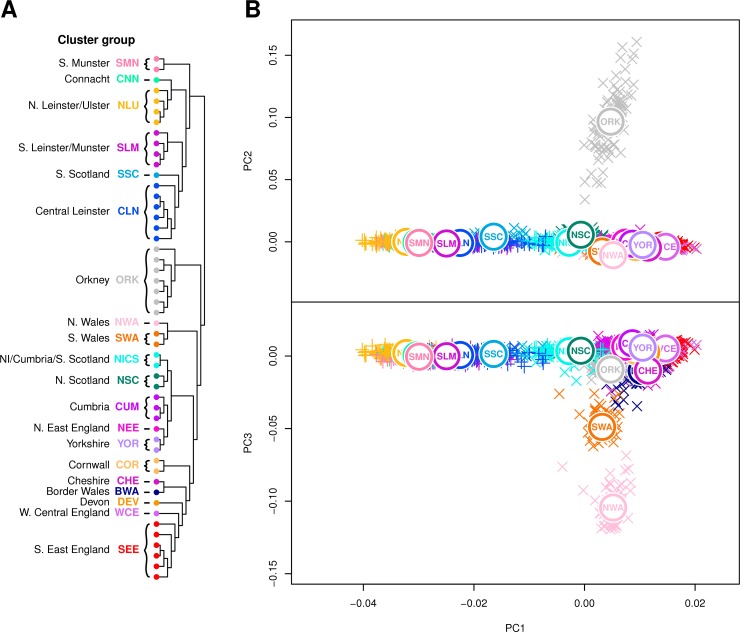
Principal components 2 and 3 of combined Irish and British coancestry matrix.(A) fineSTRUCTURE clustering dendrogram for combined Irish and British data, with cluster groups defined as in Fig 2. Immediately following the principal inter-island split, Orkney and Wales branch in sequence, consistent with previous observations. (B) Principal component analysis (PCA) of haplotypic similarity based on the ChromoPainter coancestry matrix, coloured by cluster group with their median locations labelled. PC2 captures an Orkney split, while PC3 captures a Welsh split.